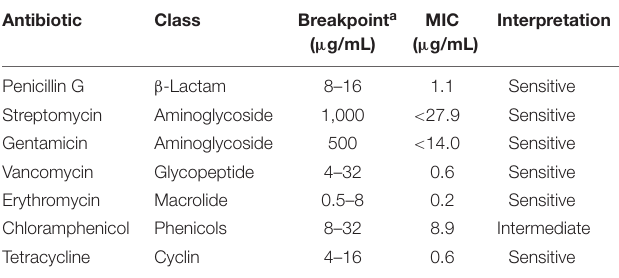
TABLE 2 | Mean inhibitory concentration of various antibiotics against Enterococcus faecium LCW 44. Antibiotic